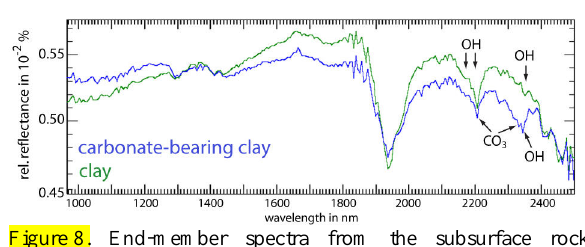
Figure 8. End-member spectra from the subsurface rock laboratory. Carbonate absorption features allow the identification of carbonate-bearing clay; data collected with the HySpex SWIR-320me